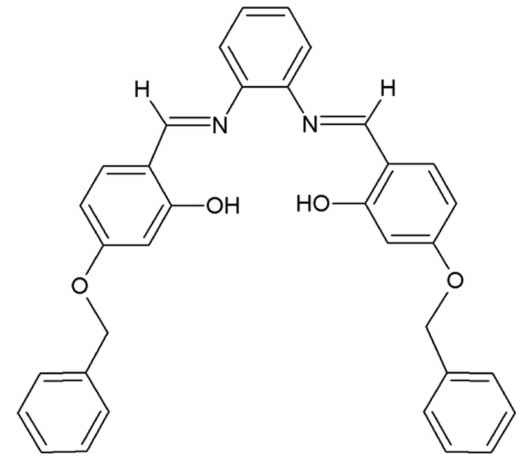
Fig. 1. The configuration of the C4 N1 imine bonds is E and